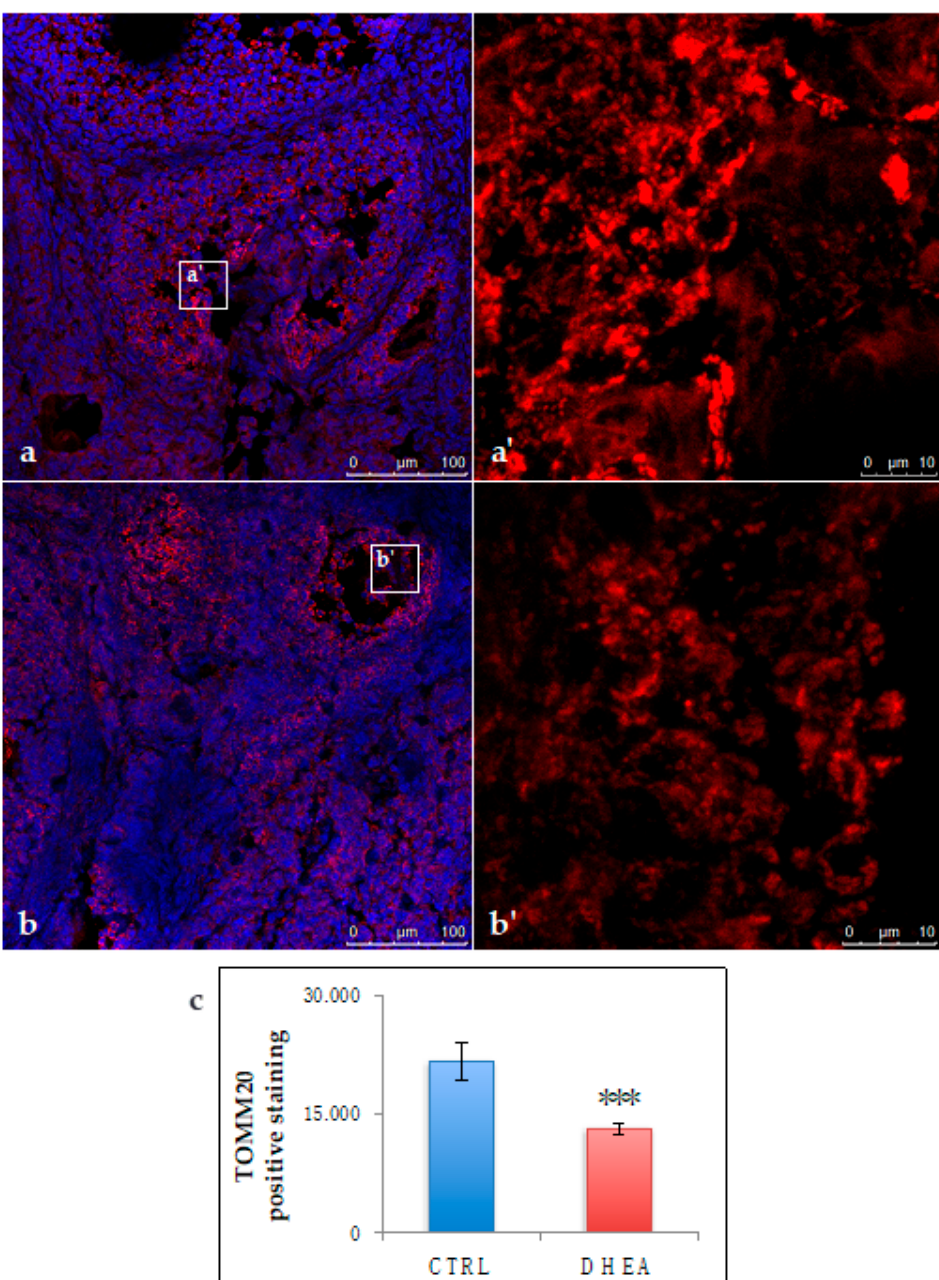
Figure 7. Immunolocalization and quantification of translocase of outer mitochondrial membrane 20 Figure 7 (TOMM20) positive staining (red). DNA is stained by DAPI (blue). Representative images of TOMM20 in CTRL ( a , a’ ) and DHEA ( b , b’ ) mice. Quantification of TOMM20 positive staining in the experimental groups ( c ). Data are presented as means ± SEM of mean pixel intensity of red fluorescence. Three mice per experimental group were employed. Experiments were done in triplicate. ***, p < 0.001, t